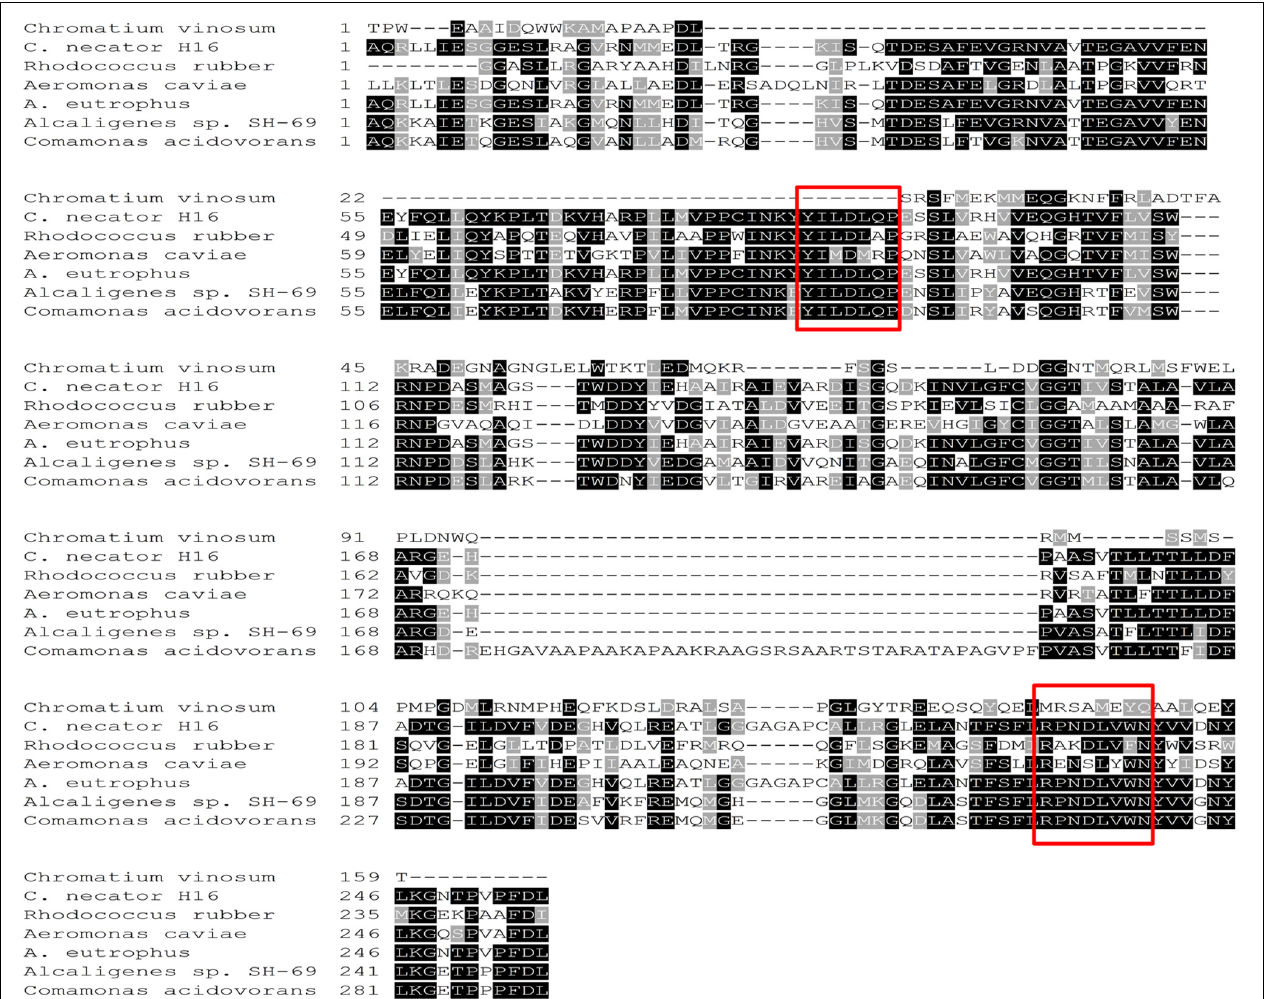
FIGURE 1 | Alignment of the deduced amino acid sequence of the PHA synthase from Comamonas acidovorans (accession no. AB009273), Alcaligenes sp. strain SH-69 (accession no. U78047), A. eutrophus (accession no. J05003), Aeromonas caviae (accession no. D88825), Rhodococcus rubber (accession no. X66407), Chromatium vinosum (accession no. 01112), and C. necator H16 (accession no. AM260479.1) (Sudesh et al., 1998). Amino acids that are identical between all the PHA synthases are identified by black boxes, whereas conserved and similar amino acids are highlighted in light gray. The red box means the selected conserved sequence regions that were used for designing degenerate